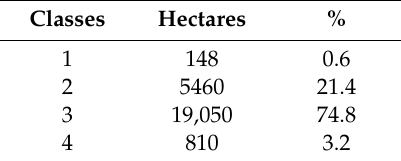
Table 14. Hazard classes of the deforestation hazard (Hd) map of deforested areas, Hd varies from 1 (lower) to 4